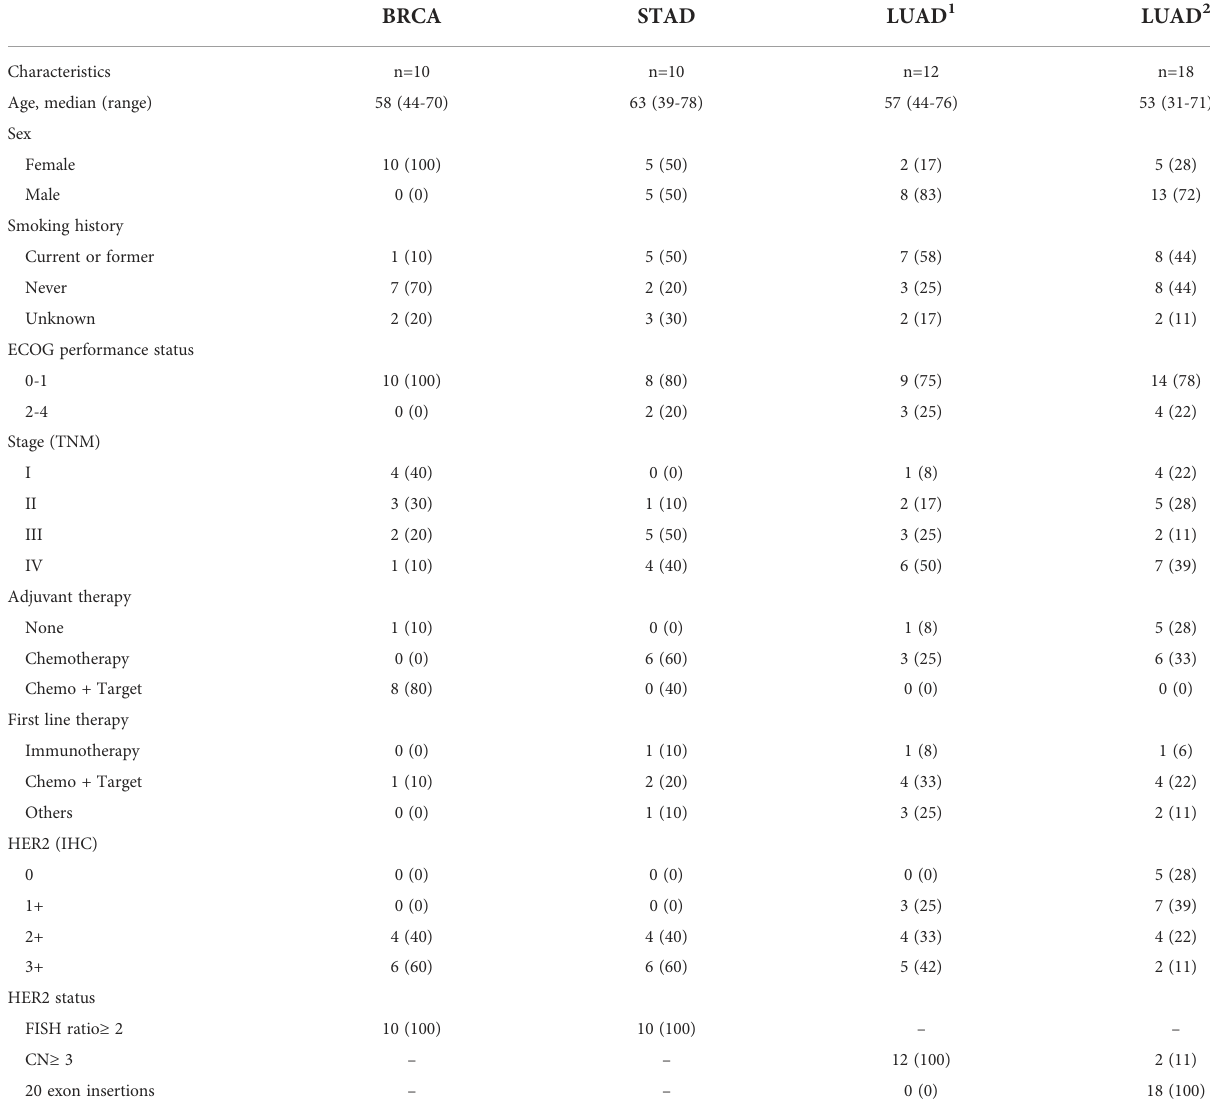
TABLE 2 Characteristics of patients enrolled for IHC analysis. BRCA STAD LUAD 1 LUAD